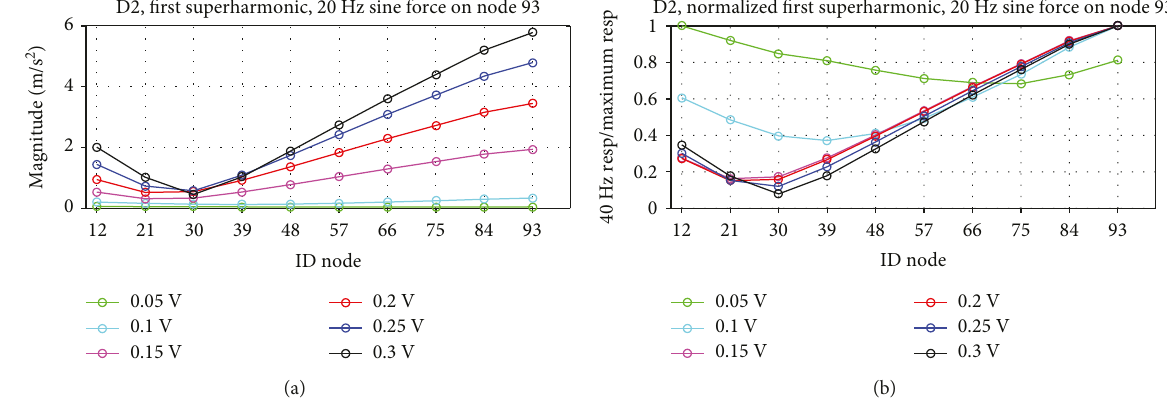
Figure 48: 40 Hz FFT magnitudes, 20Hz sine excitation force applied to node 93, D2 scenario.